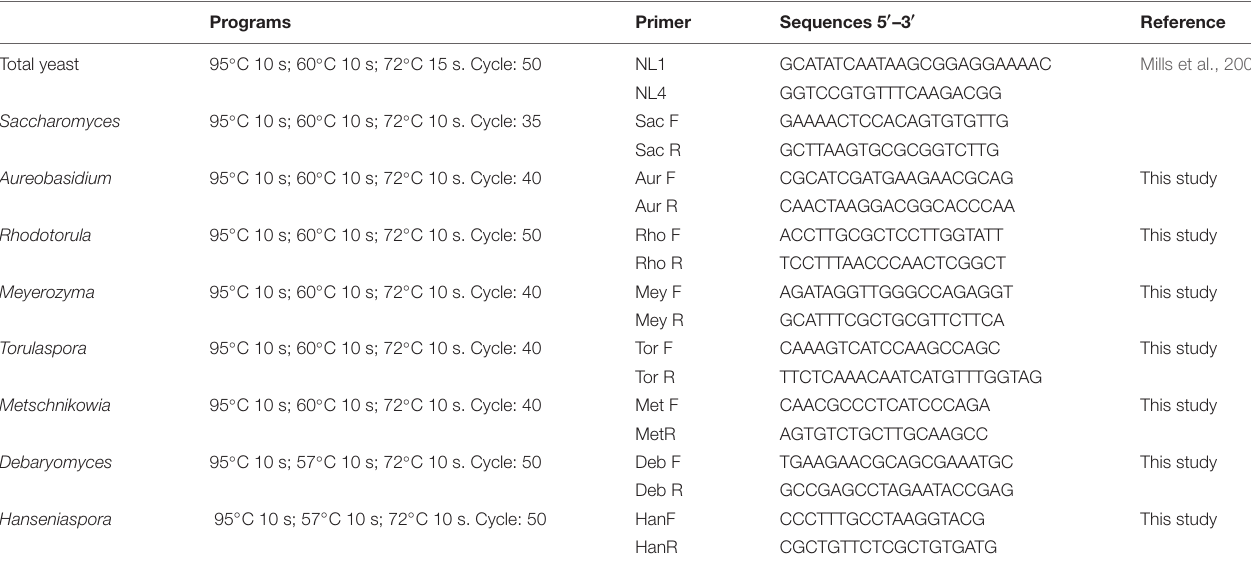
TABLE 2 | Primers and programs for quantitative